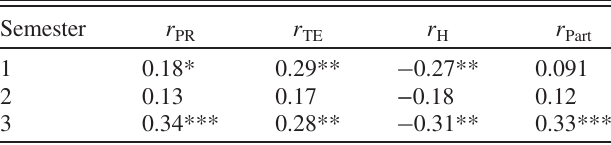
TABLE II. Correlation coefficients r between final grade, the network centrality measures PageRank (PR), Target Entropy (TE), and Hide (H), and forum participation (total threads þ comments). Asterisks show the level of statistical significance ( (cid:3) p < 0 . 05 , (cid:3)(cid:3) p < 0 . 01 , and (cid:3)(cid:3)(cid:3) p < 0 . 001 ).